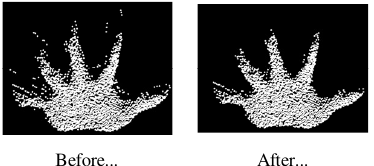
Figure 6: Remaining noise removal using the connected component